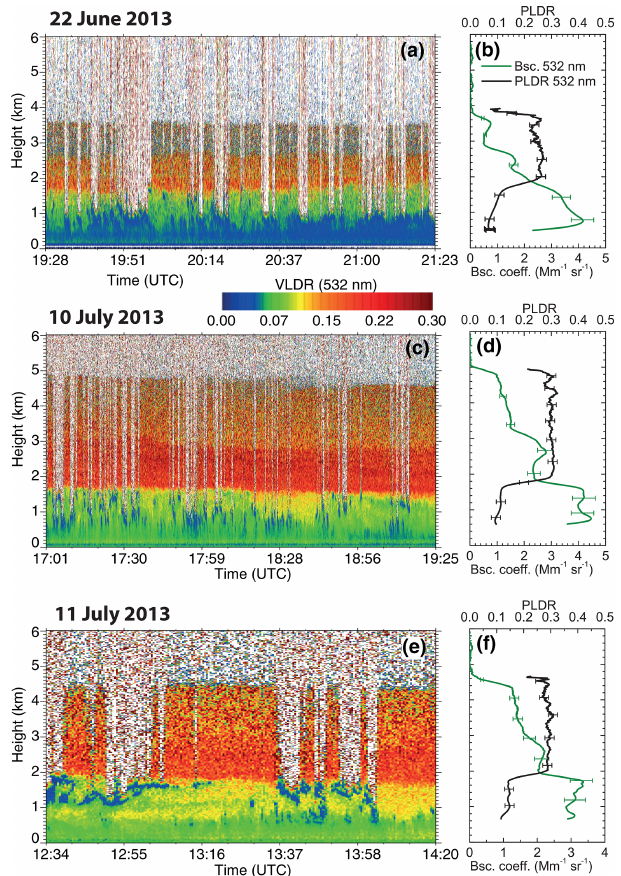
Figure 2. SALTRACE lidar observations of the Saharan Air Layer (SAL) above the marine boundary layer on 22 June (a–b) , 10 July (c–d) , and 11 July (e–f) 2013. Time–height displays of the volume depolarization ratio at 532nm (a, c, e) and the corresponding cloud- screened mean profiles (b, d, f) of the particle backscatter coeffi- cient (green line; lower x axis) and particle linear depolarization ra- tio (black line; upper x axis) at 532nm are shown. Low-level trade wind cumuli (dark blue in a , c , and e ) strongly attenuated the laser light, indicated by the noise above the clouds. The strong increase in the depolarization ratio indicates the lower boundary of the SAL at approximately 1.8–2.0km height. The top of the SAL was about 3.7km (22 June), 5.0km (10 July), and 4.5km (11 July). Local time is UTC − 4h.